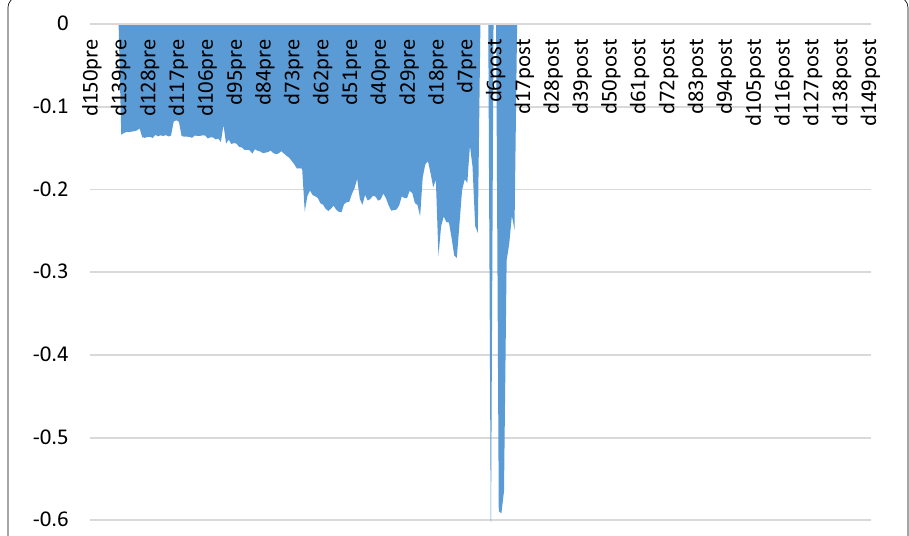
-0.6 Fig. 2 Estimates of significant herding coefficients around futures